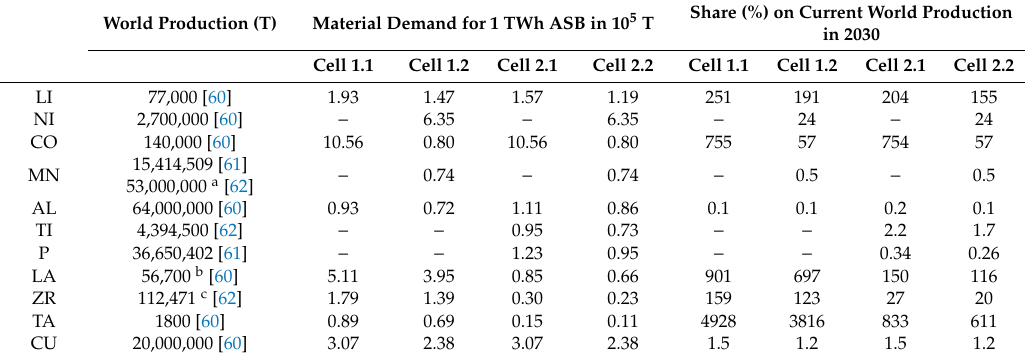
Table 2. Material demand required for 1 TWh ASB and share of demand on current world production.